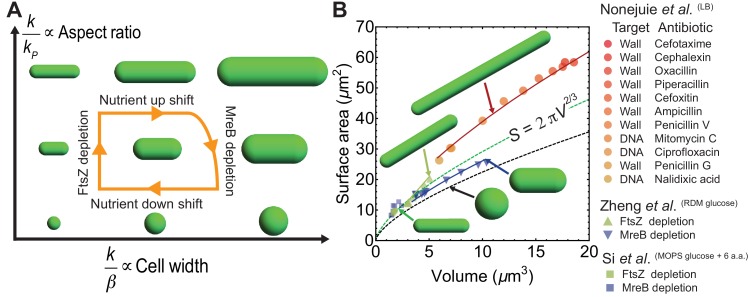
Model predictions for aspect ratio and shape control under perturbations.(A) Model parameters that control changes in cell aspect ratio (k/kP) or width (k/β). For quantification see Figure 4—figure supplement 1A. (B) Surface area vs volume for cells under antibiotic treatment (Nonejuie et al., 2013), FtsZ knockdown and MreB depletion (Si et al., 2017; Zheng et al., 2016). Solid lines are best fit obtained using our model and data from Zheng et al. (2016) (see Materials and methods). Cells with depleted FtsZ have elongated phenotypes, while depleted MreB have smaller aspect ratio and larger width. Cell wall or DNA targeting antibiotics induce filamentation. Dashed green line: S=2⁢π⁢V2/3, dashed black line: spheres.